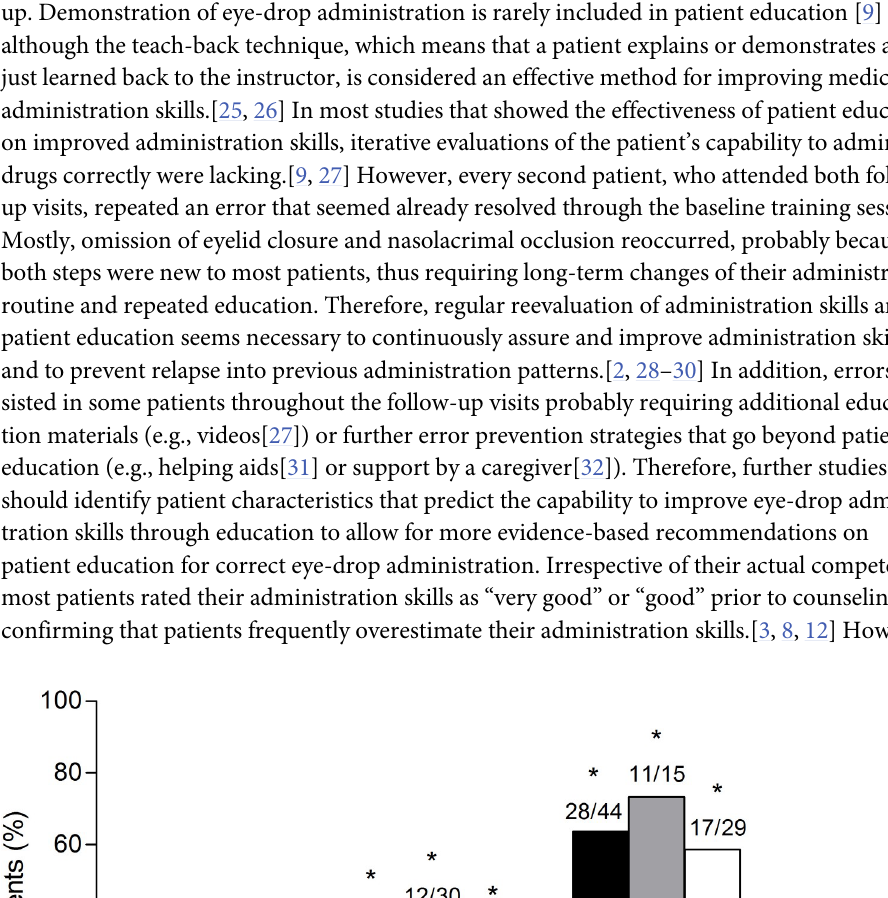
Fig 2. Patients who correctly administered their eye-drops before and after counseling. Correctly performed eye- drop administration at baseline of all patients (black), intervention group (grey), and control group (white) who regularly used eye-drops (A). Correctly performed eye-drop administration after counseling of all patients (black), intervention group (grey), and control group (white) who regularly administer eye-drops (B). Seven patients in the intervention group and one patient in the control group correctly administered eye-drops at baseline and, thus, received no counseling (C). Correctly performed eye-drop administration after counseling of all patients (black), intervention group (grey), and control group (white) using eye-drops for the first time (bottom). The eye-drop administration process comprised six steps: 1 = hand washing, 2 = instilling a single drop, 3 = instillation into the conjunctival sac, 4 = eyelid closure for approximately one minute, 5 = concomitant nasolacrimal occlusion, and 6 = dropper tip was not touched. � significant compared to baseline (p � 0.001).